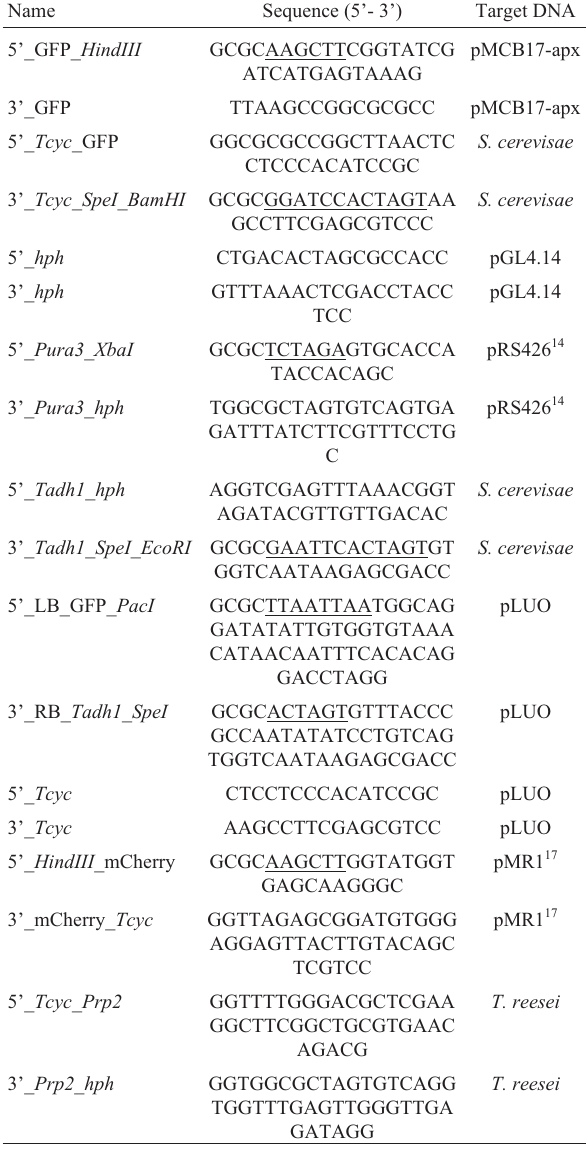
Table 1 - Primers used in this